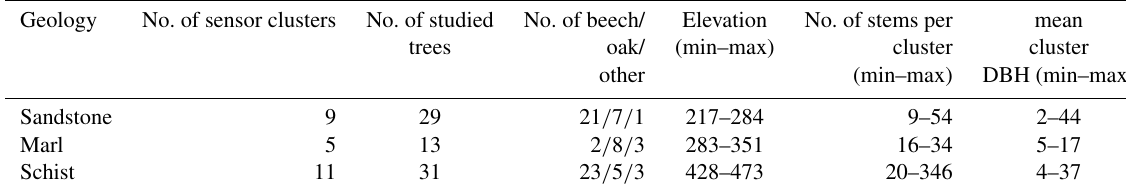
Table 2. Sensor cluster